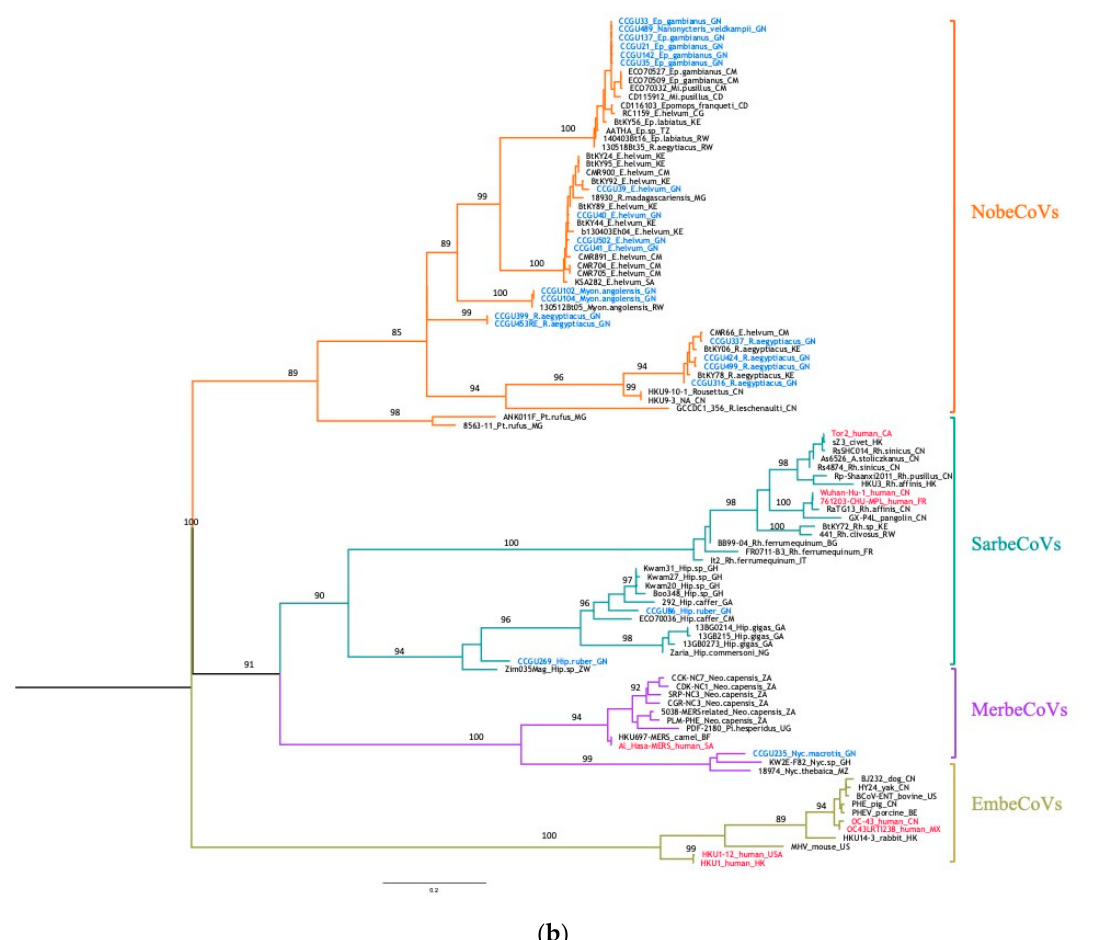
Figure 2. Maximum likelihood (ML) consensus trees derived from coronavirus sequences in the RNA-dependent RNA-polymerase partial nucleotide sequences (374 unambiguously aligned base pairs). ( a ) consensus tree derived from 78 alphacoronaviruses; ( b ) consensus tree derived from 102 betacoronaviruses. Phylogenetic tree analysis was performed using the GTR + F + I + 4 Γ nucleotide substitution model and 1000 bootstrap resampling. Sequences in blue refer to the new bat CoVs detected in this study. Human CoVs are highlighted in red. Branch supports > 0.75 are indicated on the trees. Trees were generated as indicated in Material and Methods and edited with increasing nodes and midpoint rooting in FigTree. Details on reference sequences are provided in Supplementary Table S1. Abbreviations of bat genera are as follows: Ep— Epomophorus ; R— Rousettus ; E— Eidolon